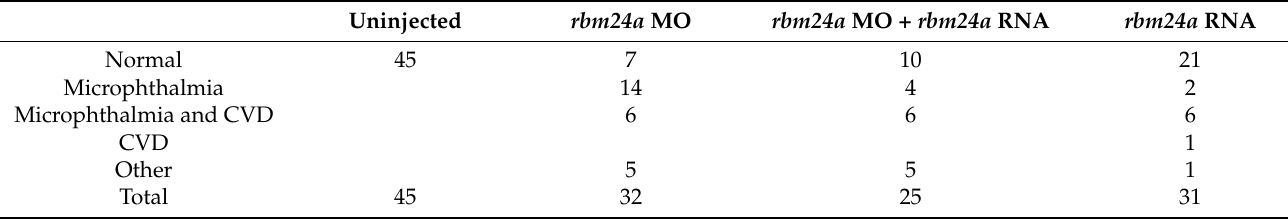
Table 2. Number of phenotypes associated with uninjected, rbm24a knockdown, rbm24a knockdown with rbm24a RNA, and rbm24a RNA alone. Uninjected